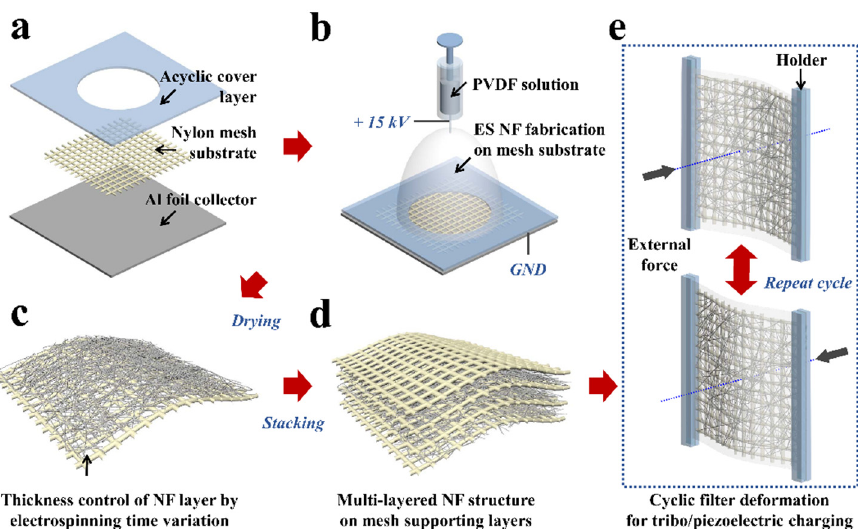
Figure 1. Schematics of the multilayer filter fabrication and electrostatic charging process. ( a , b ) PVDF NF membrane fabrication on a nylon mesh substrate by the electrospinning method. ( c , d ) Fabrication of a triple-layer filter by stacking layers of the PVDF NF membrane-nylon mesh. ( e ) Generation of electrostatic charges on the filter by the tribo/piezoelectric effect between nylon and PVDF materials in cyclic external force.